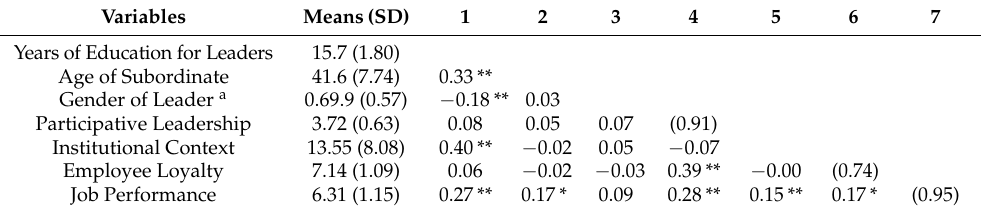
Table 1. Descriptive statistics and